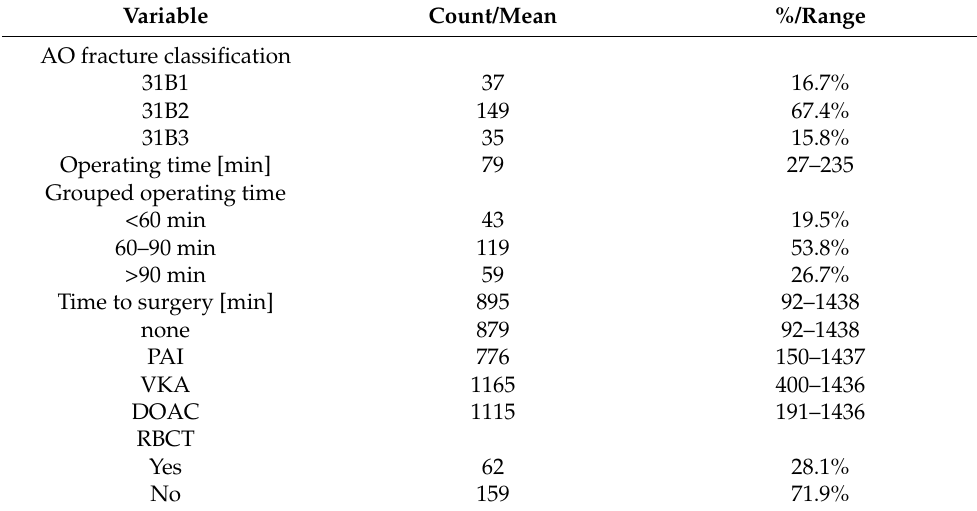
Table 2. Perioperative